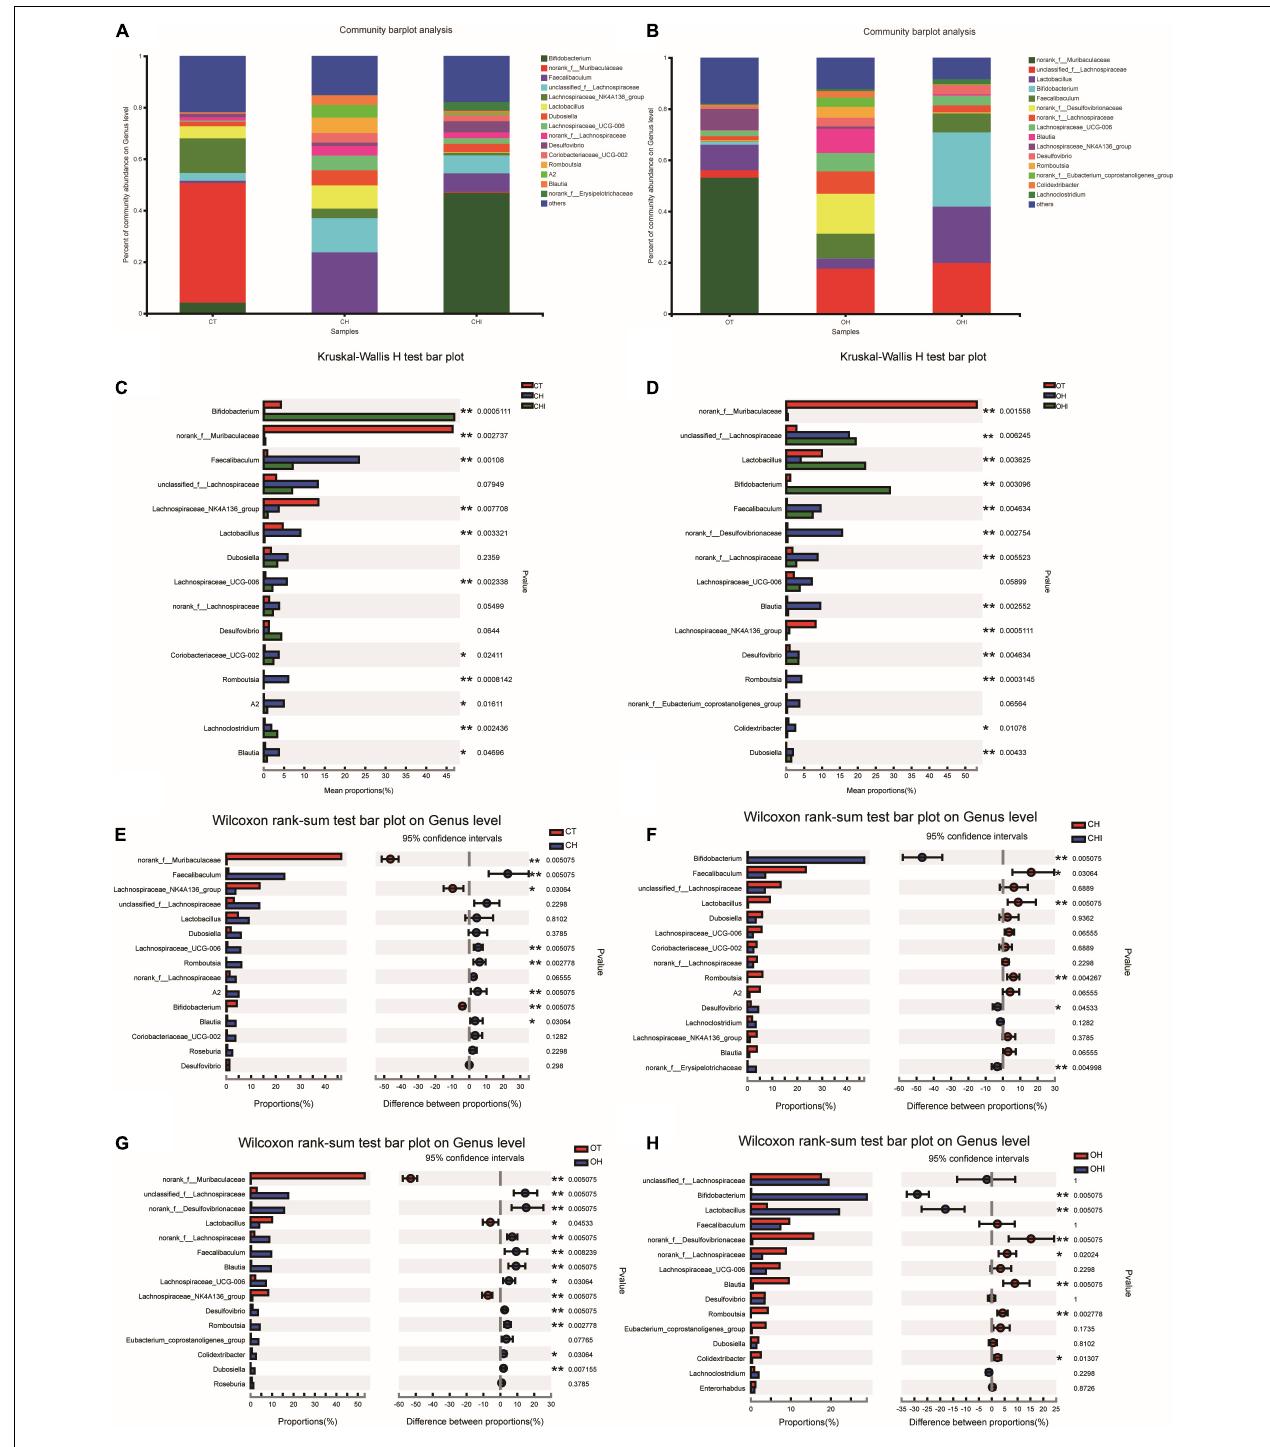
FIGURE 4 | Top 15 microbiota relative abundance of cecal microbiota in genus level. (A) Relative abundance of cecal microbiota for CT, CH, and CHI groups on genus level. (B) Relative abundance of cecal microbiota for OT, OH, and OHI groups on genus level. (C) The cecal microbiota showed differential abundance at the genus level between the CT, CH, and CHI groups. (D) The cecal microbiota showed differential abundance at the genus level between the OT, OH, and OHI groups. (E) The cecal microbiota showed differential abundance at the genus level between the CT and CH groups according to t -tests. (F) The cecal microbiota showed differential abundance at the genus level between the CH and CHI groups according to t -tests. (G) The cecal microbiota showed differential abundance at the genus level between the OT and OH groups according to t -tests. (H) The cecal microbiota showed differential abundance at the genus level between the OH and OHI groups according to t -tests. *Indicated there was a significant difference compared with OT ( p < 0.05), ** indicated there was a significant difference compared with OT ( p < 0.01).